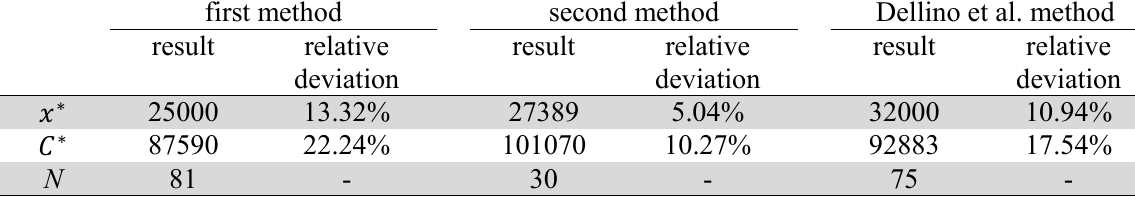
Results and relative deviation from reference for three methods on EOQ